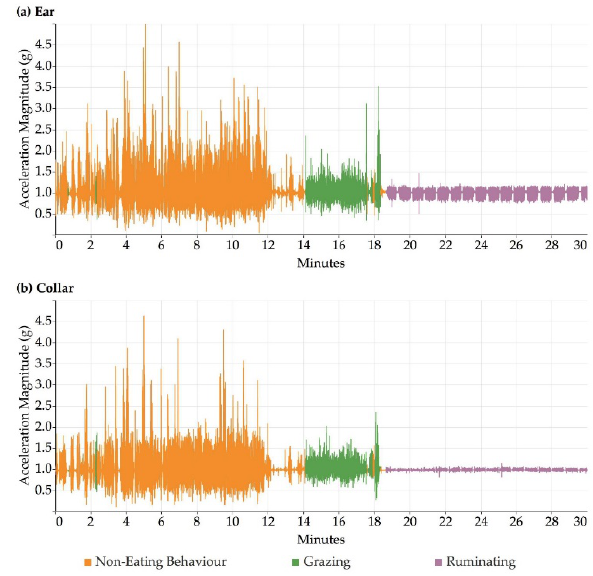
Figure 2. Example graph showing accelerometer data extracted from sensors mounted on one sheep in two locations, ear ( a ) and collar ( b ), over 30 min showing grazing, non-eating and ruminating behaviour over time.